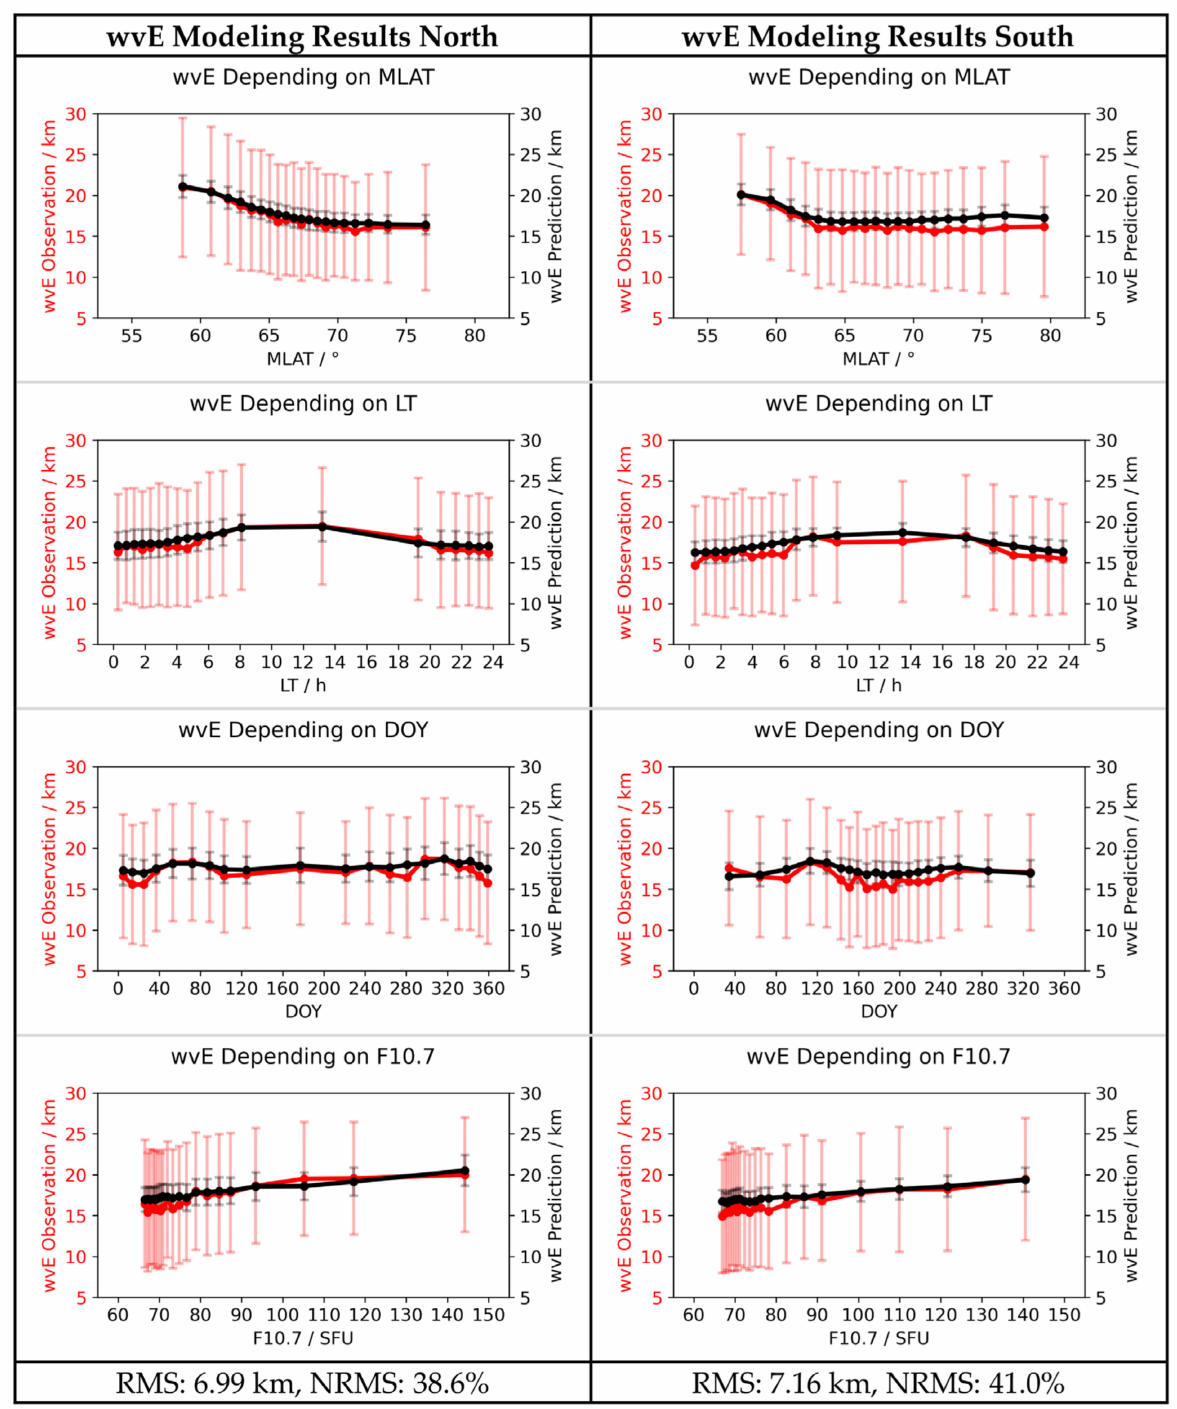
Figure 4. Observed (red) and predicted (black) wvE trends for the modeling dataset. Left column: Northern Hemisphere. Right column: Southern Hemisphere. Last row: RMS and NRMS deviation between observation and